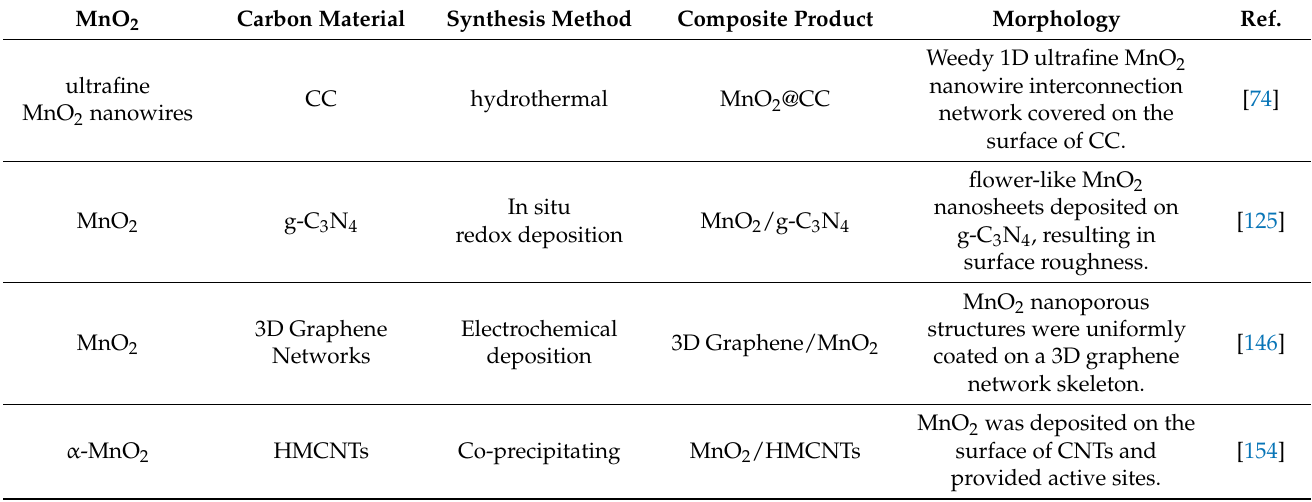
Table 1. Summary of preparation methods, products, and morphological characteristics of synthesiz- ing MnO 2 -carbon